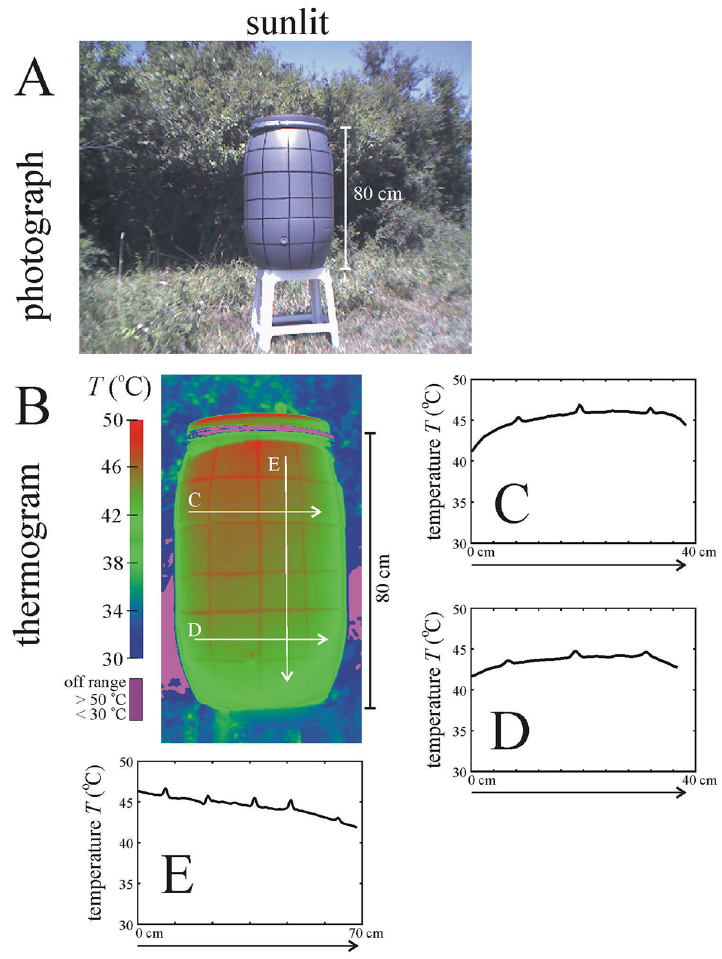
Figure 2. Photograph ( A ) and thermogram ( B ) of the sunlit black-striped grey barrel used in the field experiment. The barrel’s surface temperature T (°C) along the horizontal and vertical white arrows in the thermogram are shown in panels ( C–E